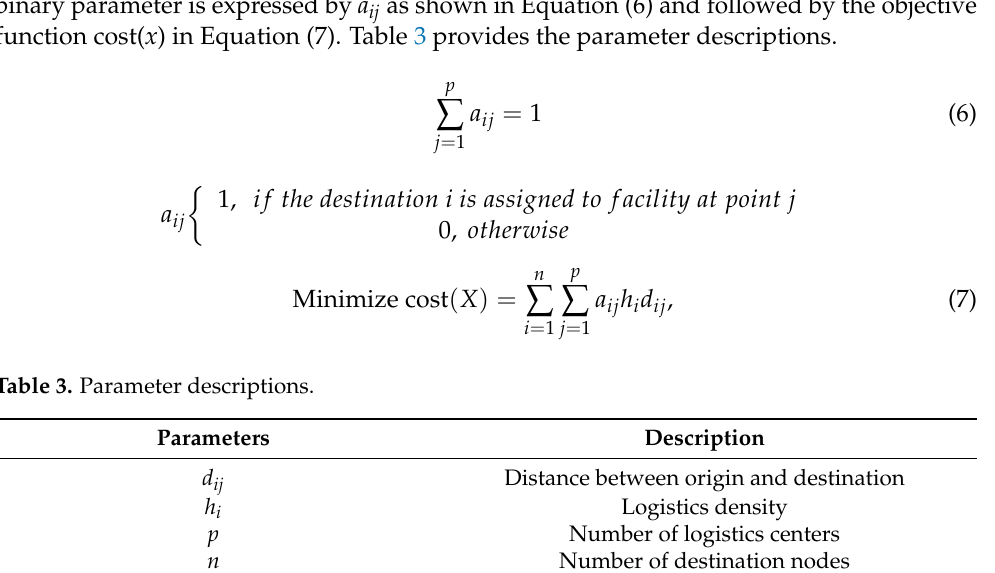
Binary parameter for assigned case